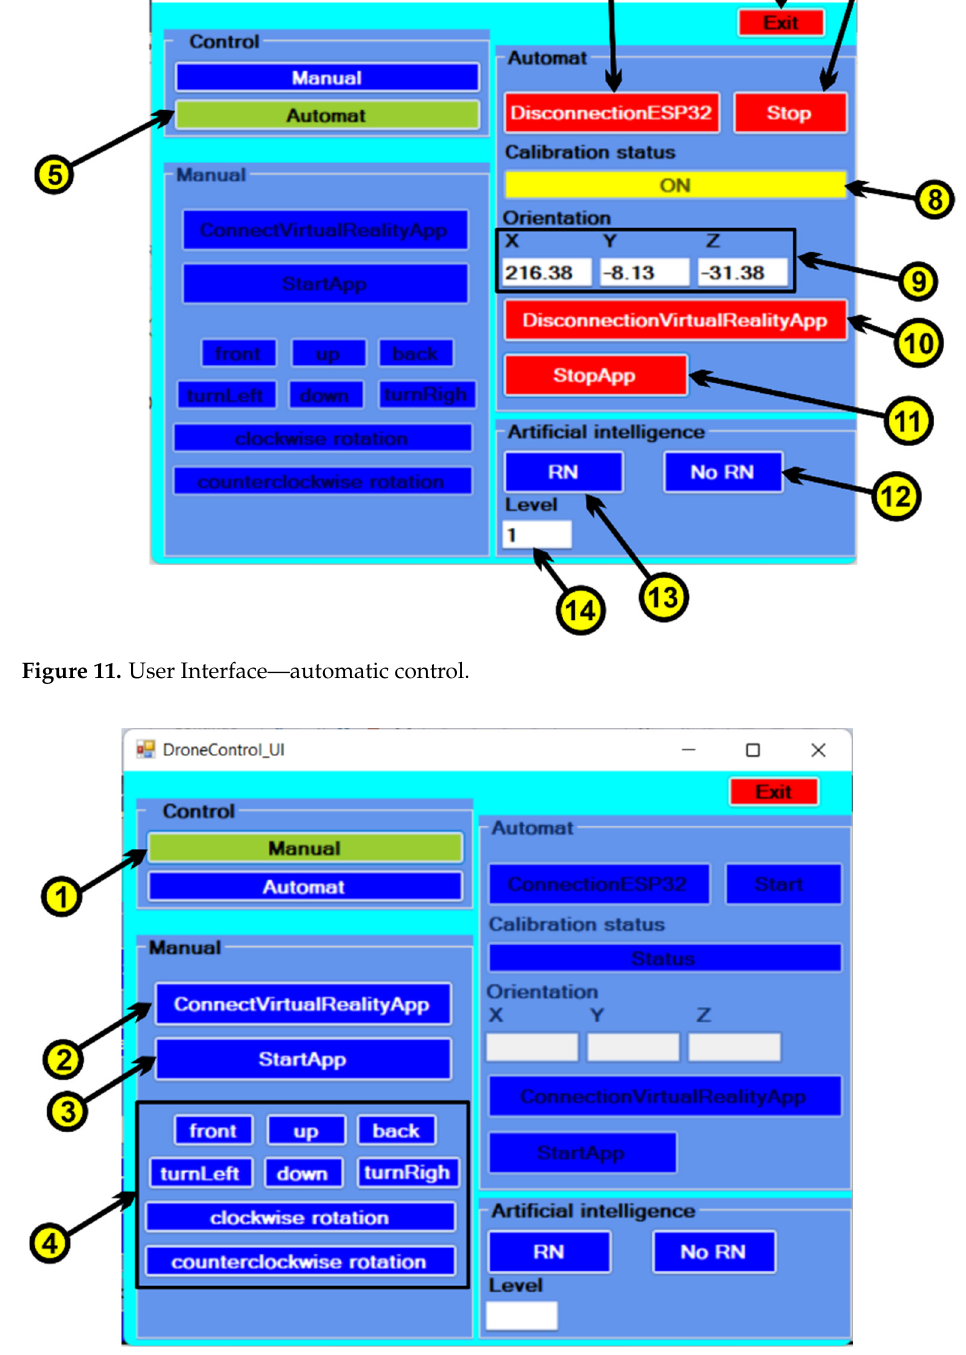
Figure 11. User Interface—manual control. Figure 12. User Interface—manual